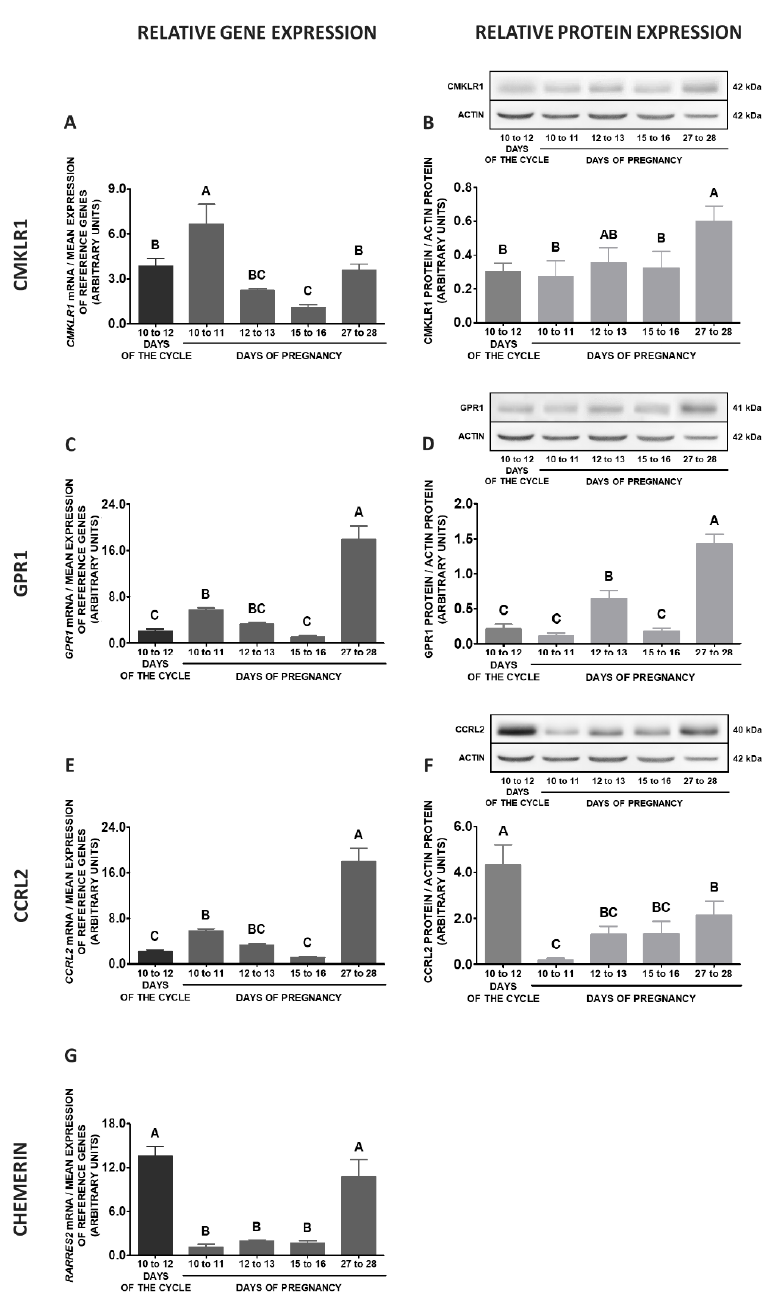
Figure 10. Chemerin system expression in the porcine preoptic area (POA)—pregnancy vs. oestrous cycle. Gene and protein expression of chemokine-like receptor 1 (CMKLR1; A and B ), G protein-coupled receptor 1 (GPR1; C and D ) and C-C motif chemokine receptor-like 2 (CCRL2; E and F ), as well as chemerin ( RARRES2 ) mRNA content ( G ) in the porcine POA on days: 10 to 11, 12 to 13, 15 to 16 and 27 to 28 of pregnancy, and on days 10 to 12 of the oestrous cycle. Gene expression was determined by qPCR. Protein expression was determined by Western blotting; upper panels: representative immunoblots; lower panels: densitometric analysis of CMKLR1/GPR1/CCRL2 proteins relative to actin protein. Representative actin blots are identical for all chemerin receptors though proteins have been analysed on different gels. Results are presented as means ± SEM ( n = 5). Bars with different superscripts differ (one-way ANOVA at p < 0.05 followed by Tuckey post-hoc test at p < 0.05).